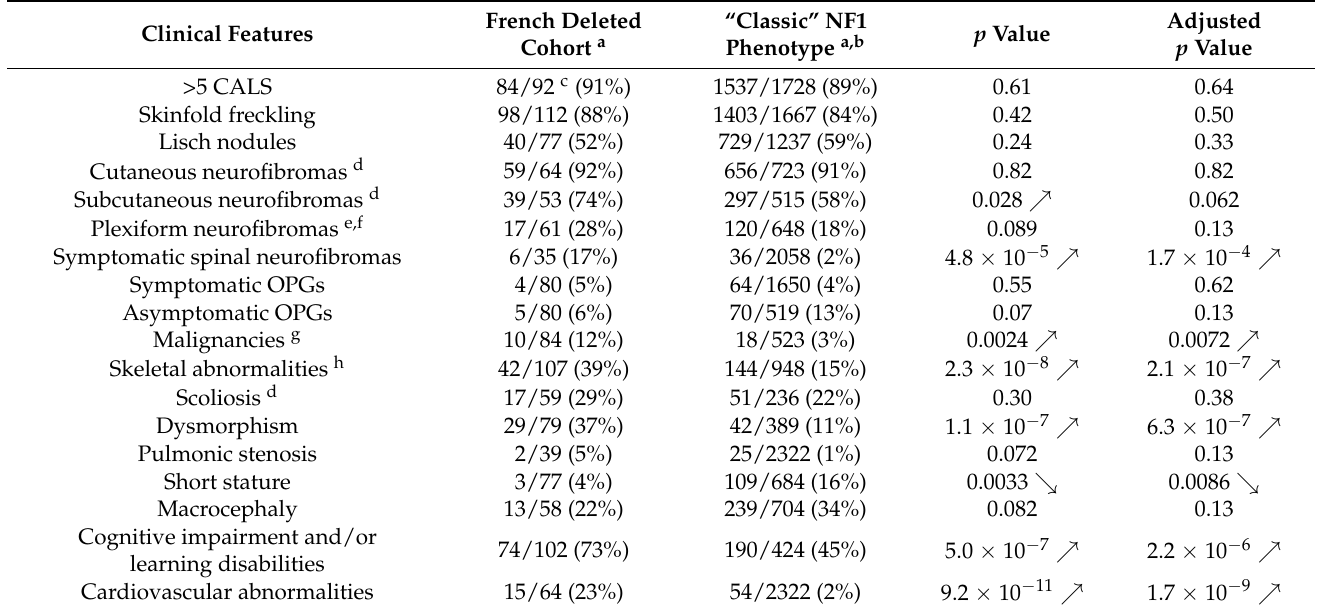
Table 2. Comparison of the main clinical findings in the French deleted cohort with “classic”